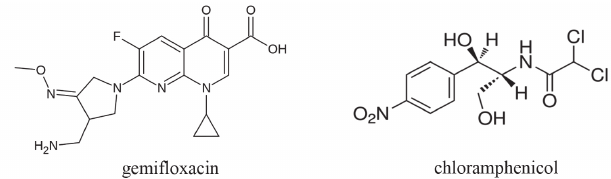
FIGURE 1 - Chemical structure of gemifloxacin and